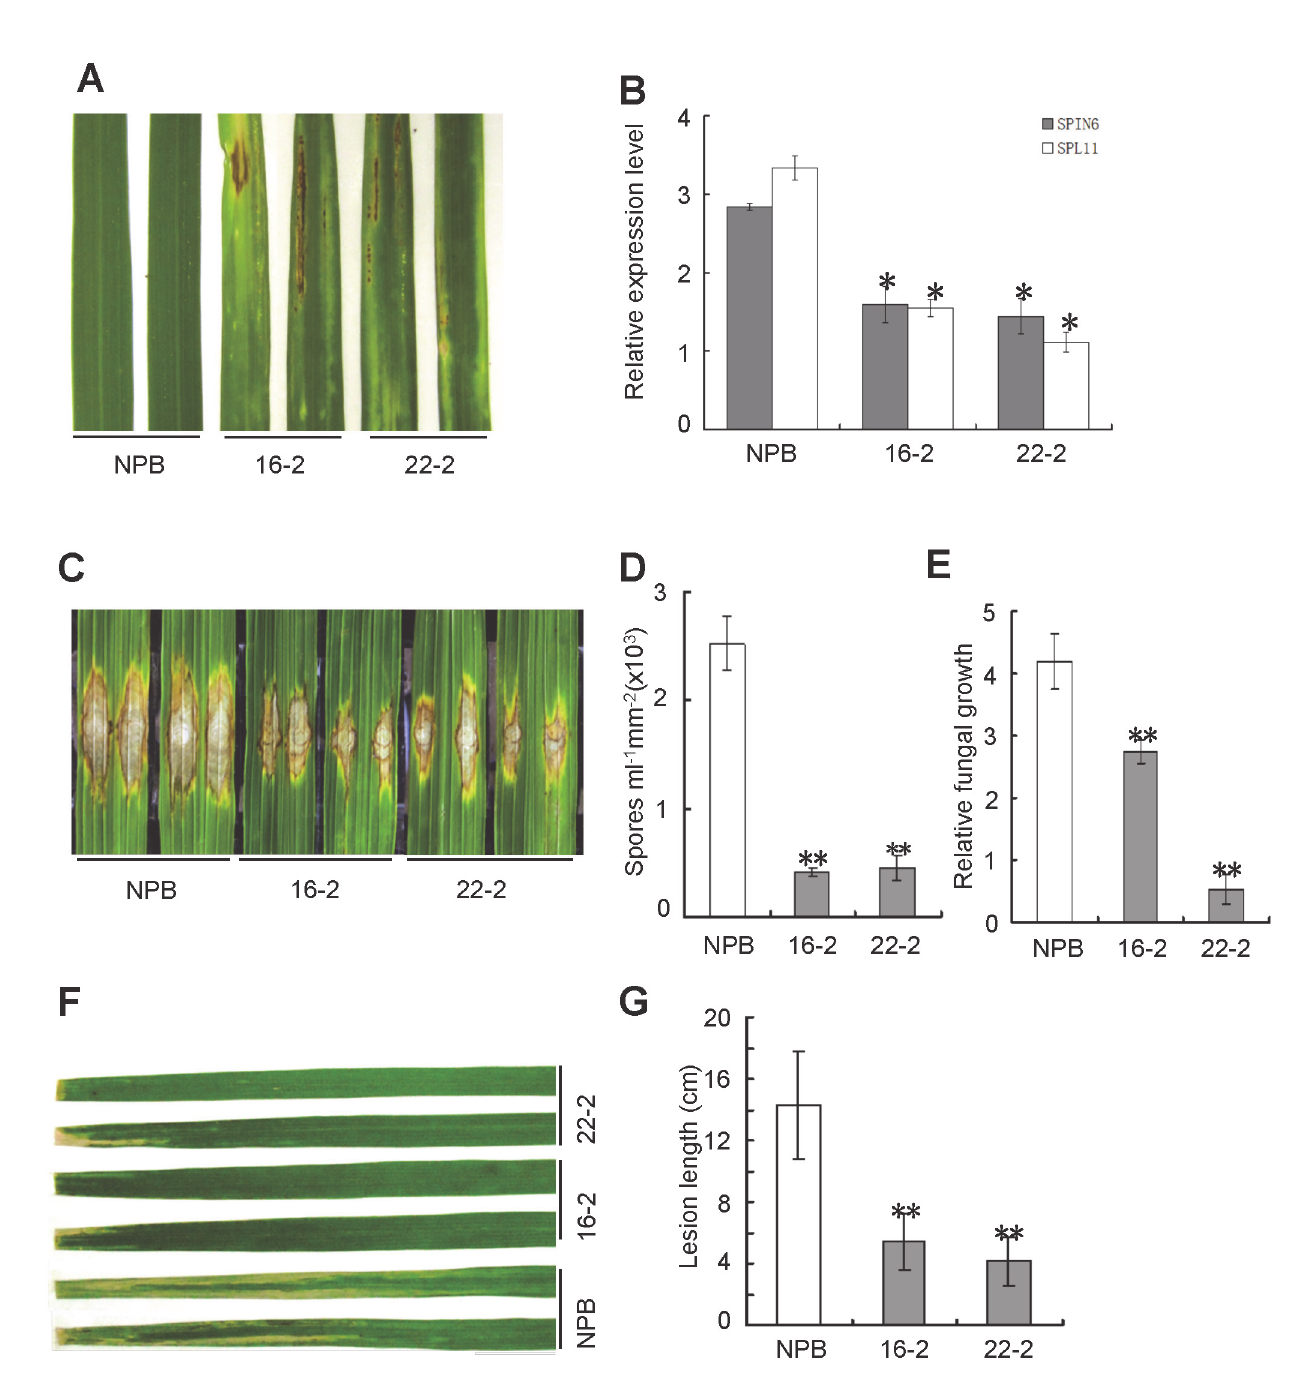
Figure 3. Knock-down of Spin6 results in cell death phenotypes and enhanced resistance to the rice blast pathogen M . oryzae and the bacterial blight pathogen Xoo in rice. (A) Cell death phenotypes of the Spin6 RNAi silencing lines. Japonica rice Nipponbare (NPB) is the wild type, and 16 – 2 and 22 – 2 are Spin6 RNAi lines. (B) The relative expression level of Spin6 and Spl11 in the wild type and Spin6 RNAi lines as determined by real-time quantitative PCR. The data were normalized with ubiquitin. (C) Lesion-size of the Spin6 RNAi lines and the wild type plants inoculated with M . oryzae isolate RO1 – 1. (D) Number of M . oryzae spores produced by lesions on the Spin6 RNAi lines and the wild type. (E) Relative M . oryzae biomass in lesions in the Spin6 RNAi lines and the wild type. (F) Lesion-size of the Spin6 RNAi lines and the wild type infected with Xoo strain race 6. (G) Bacterial blight lesion length in the Spin6 RNAi lines and the wild type. Values are means and standard errors of three replications. Significance was determined at * P < 0.05 and ** P < 0.01 (n (cid:1) 3) with a t -test.